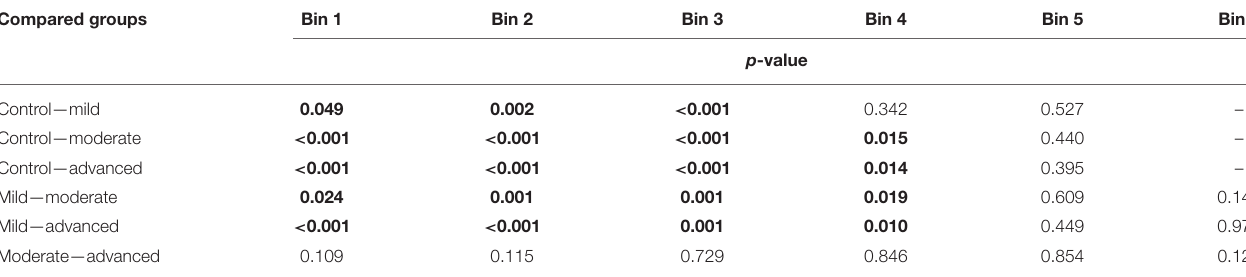
TABLE 2 | Between glaucoma severity groups comparisons for each of the 6 SAP sensitivity bins . Compared